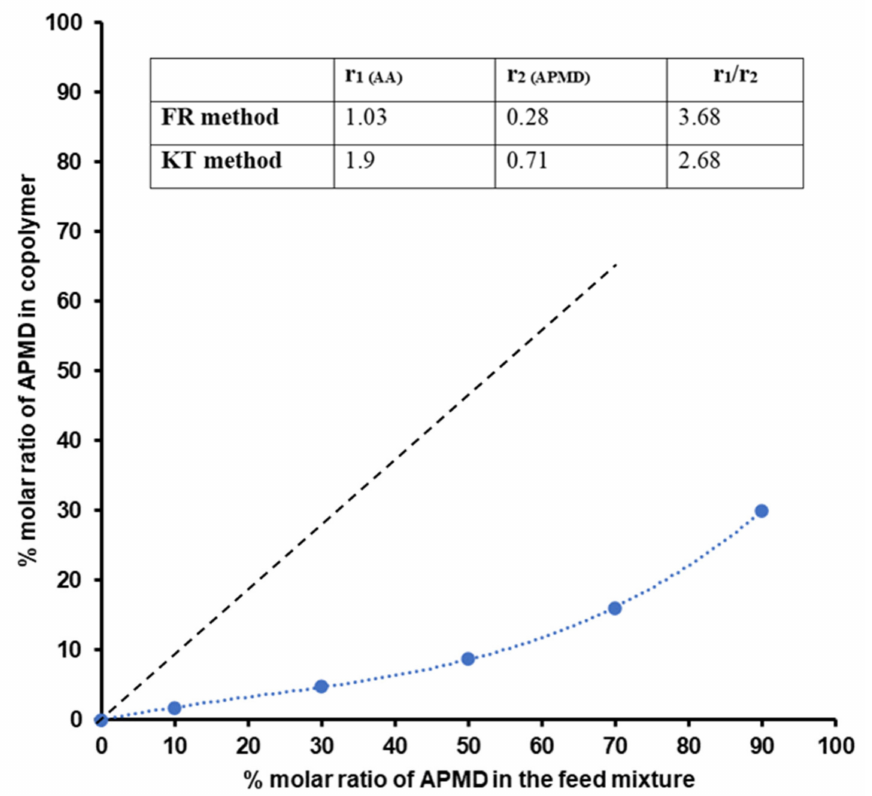
Figure 2. Composition of the copolymers as a function of APMD in the feed mixture. The dashed black line indicates the expected composition if the reactivity of the monomers was equivalent. Inset: reactivity ratios of acrylic acid (AA) and APMD, determined by the Finemann–Ross (FR) and Kelen–Tüd ó s (KT)